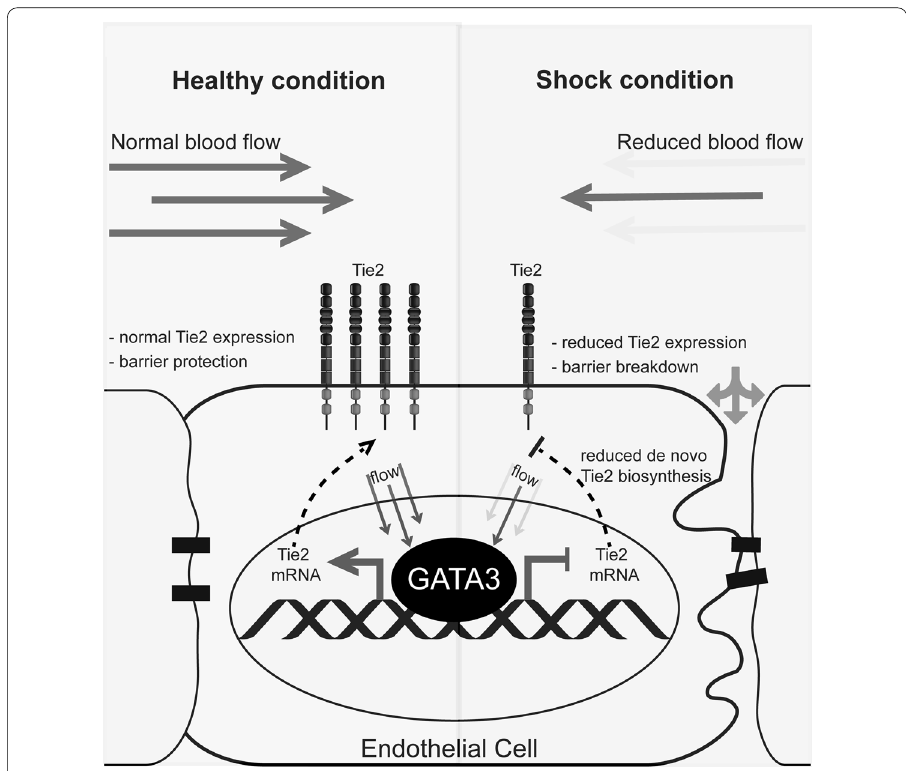
Fig. 6. Schematic illustration of the flow-regulated GATA3-dependent attenuation of endothelial